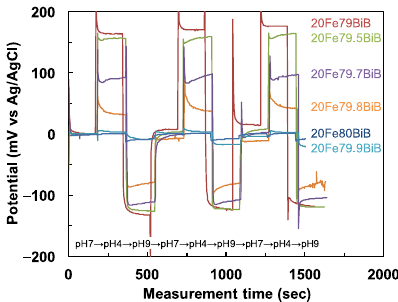
Figure 1. Change in potential with measurement time for 20Fe y BiB glasses in pH7, pH4 and pH9 buffer solutions.